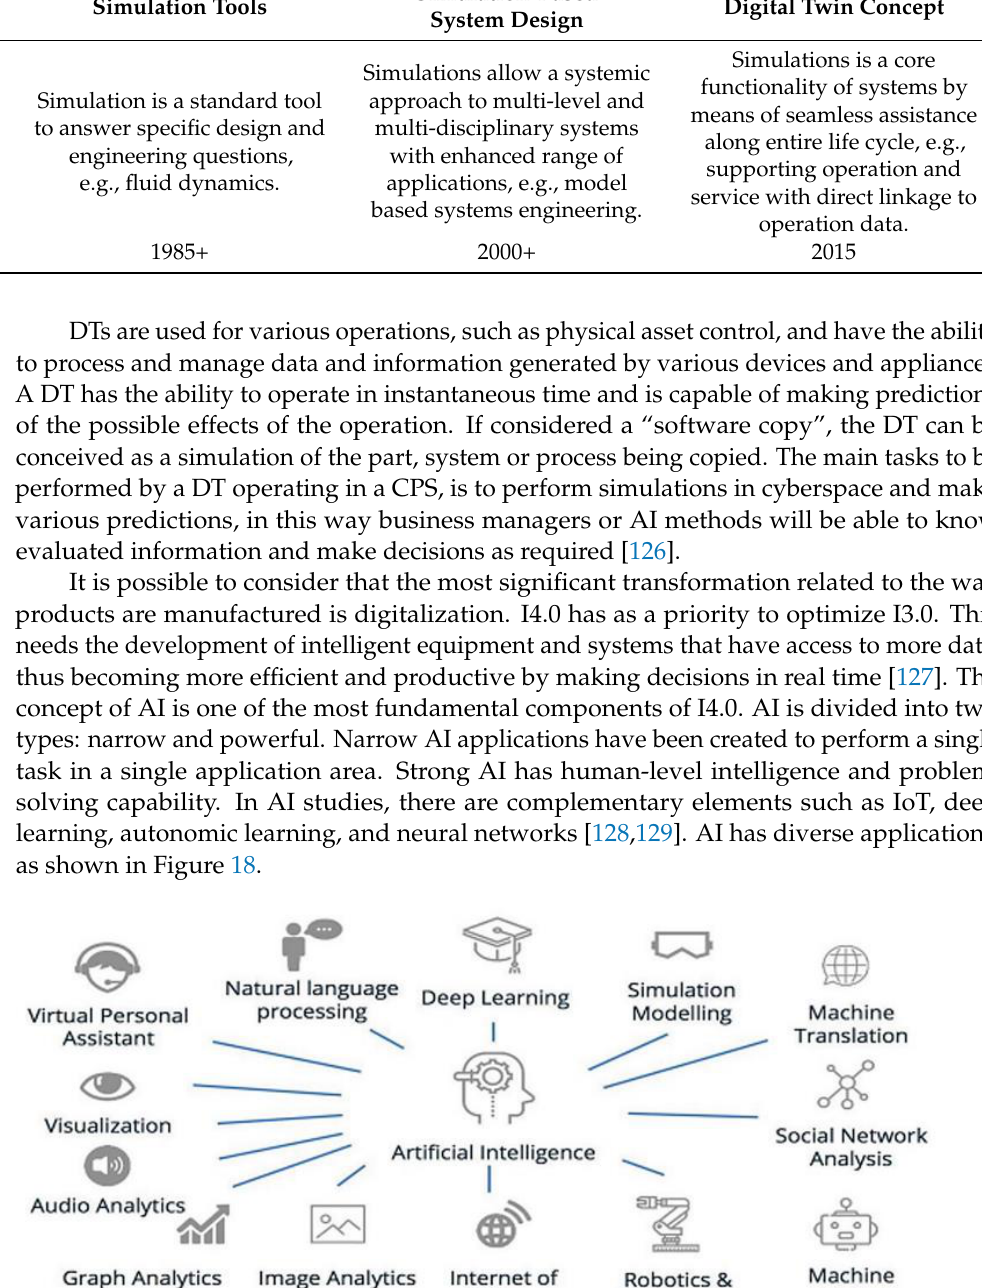
Table 3. Evolution of the simulation modeling paradigm